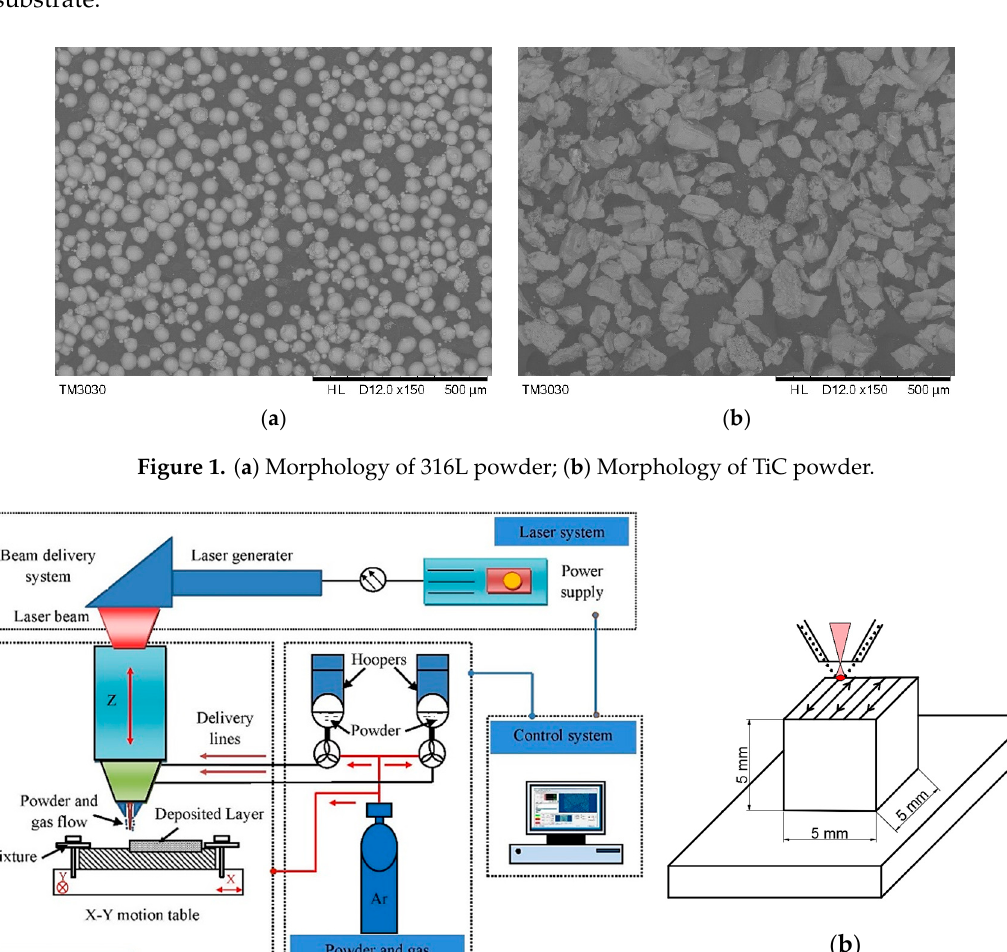
Figure 1. ( a ) Morphology of 316L powder; ( b ) Morphology of TiC powder.